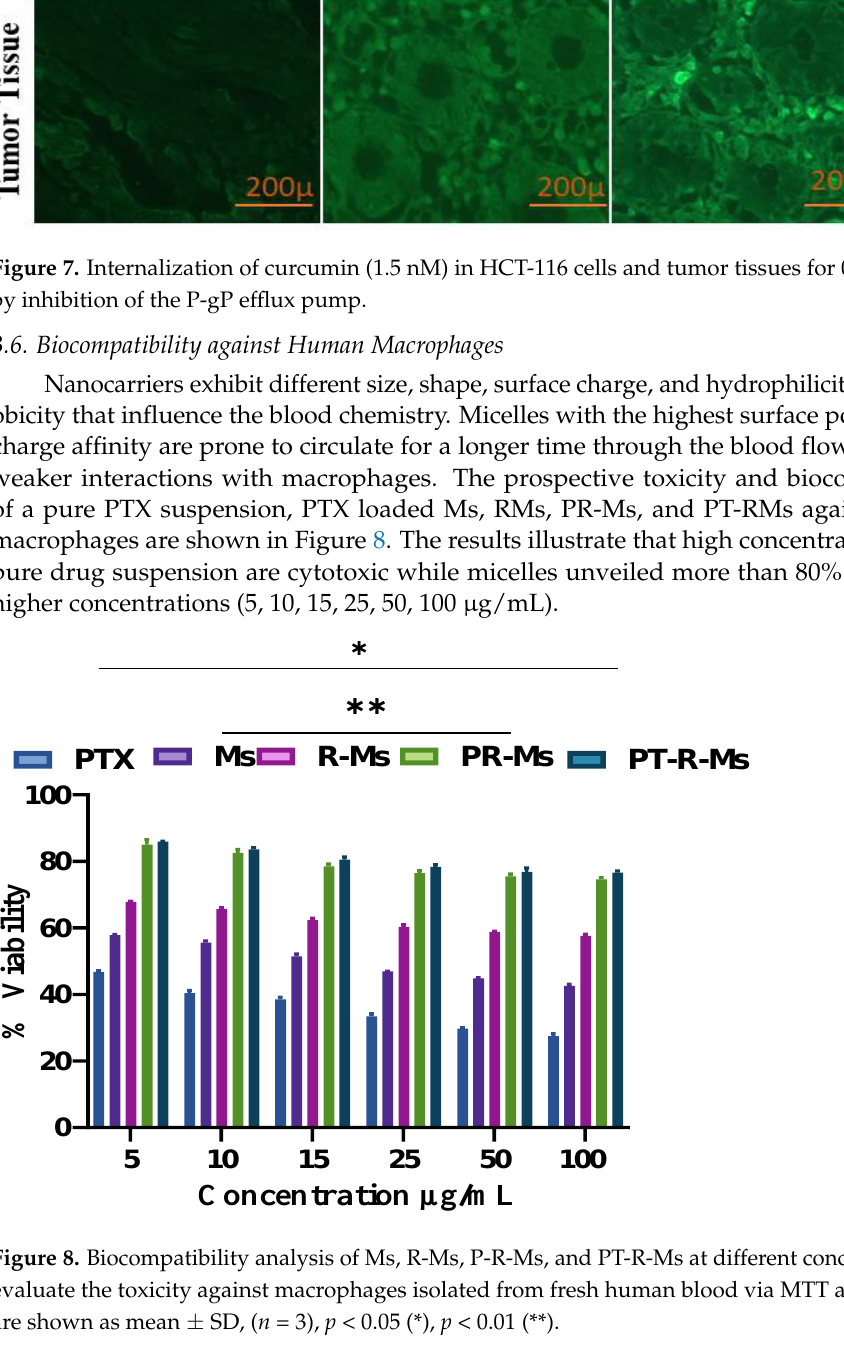
Figure 8. Biocompatibility analysis of Ms, R-Ms, P-R-Ms, and PT-R-Ms at different concentrations to evaluate the toxicity against macrophages isolated from fresh human blood via MTT assay . Re- sults are shown as mean ±SD, ( n = 3), p < 0.05 (*), p < 0.01 (**).